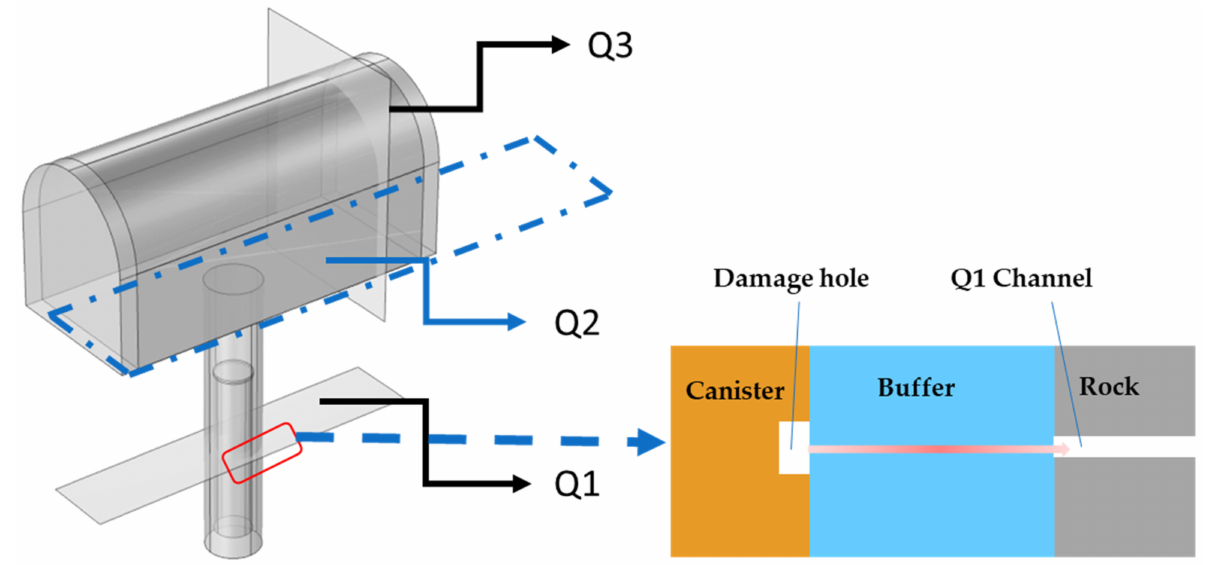
Figure 8. Schematic illustration for the Q1 transport path of radionuclide. Table 5. Parameter values of radionuclides for simulation in transient